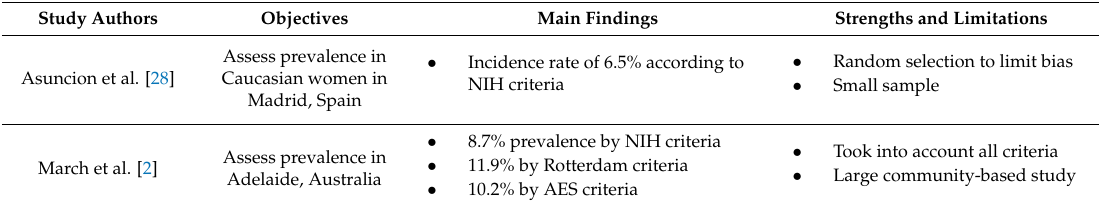
Table 3. Summary of studies on prevalence in